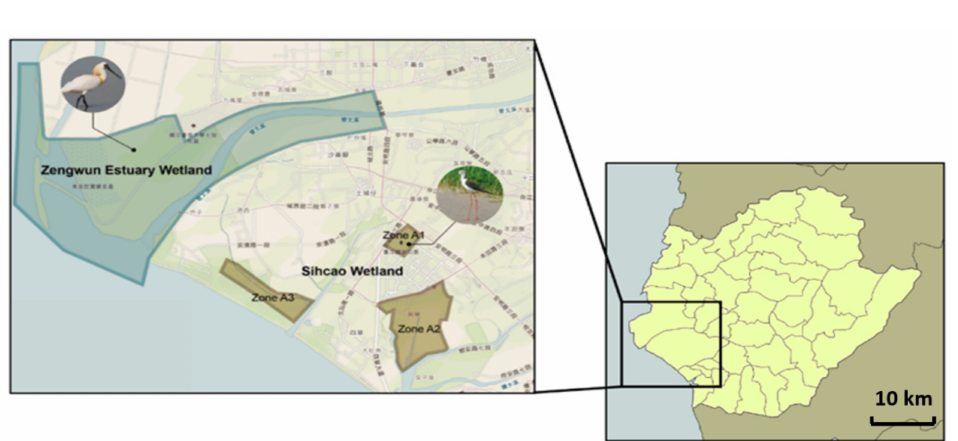
Figure 2. Wetlands of international importance (Zengwun Estuary Wetland and Sihcao Wetland (Zones A1–3)) in Tainan city with their important habitats for Black-faced Spoonbills in Zengwun and Black-winged Stilts in Sihcao wetland (retrieved from